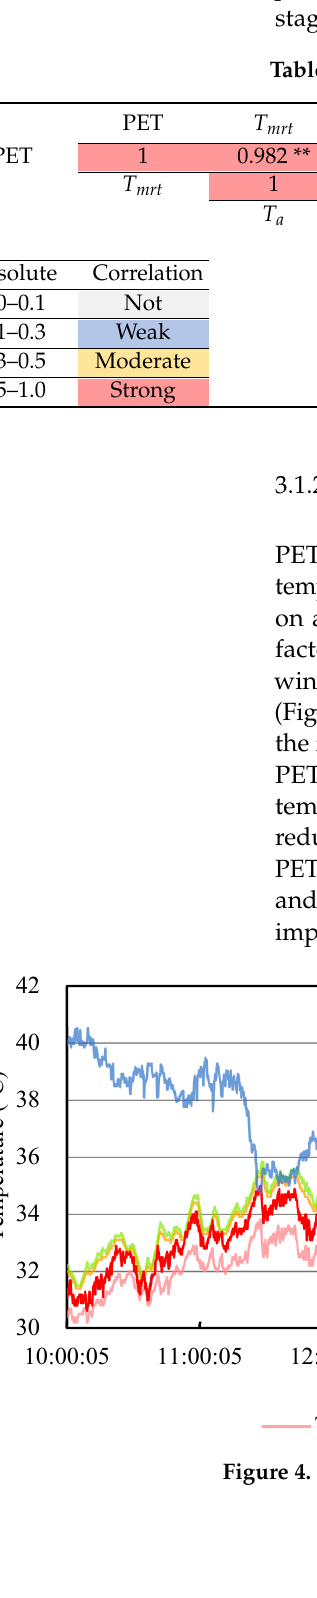
Figure 5. Temporal trend of weakly correlated thermal comfort parameters.